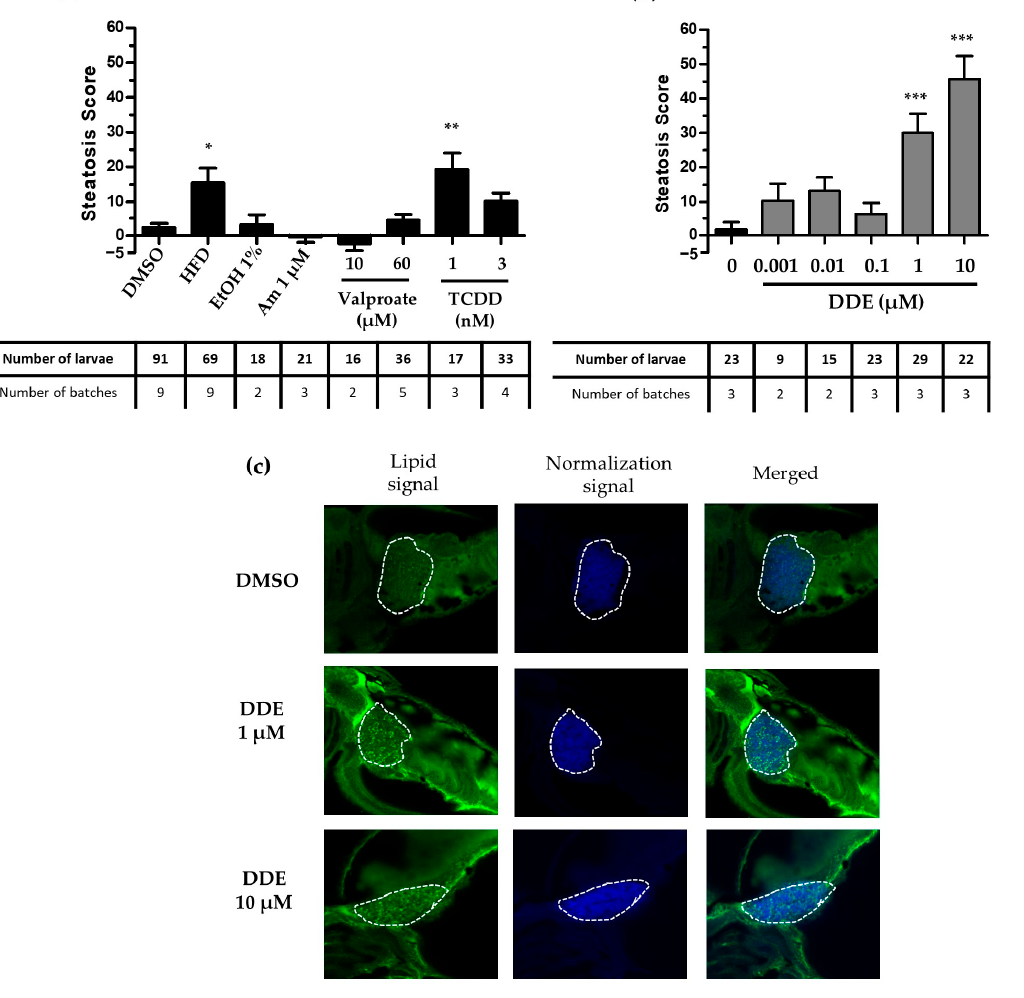
Figure 4. Screening of the steatogenic molecules and validation of the steatogenic effect with the StAZ using the transgenic zebrafish model. Zebrafish transgenic larvae at 3 days post-fertilization were exposed to positive control steatogenic conditions (HFD, ethanol, amiodarone, valproate, TCDD) ( a ), to DDE at concentrations ranging from 0.001 to 10 µ M ( b ), or to vehicle alone ( a , b ), during 48